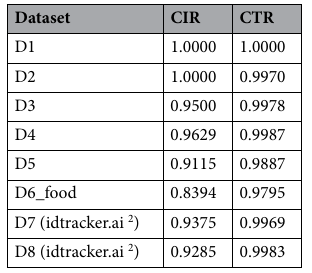
Table 3. Performance of the evaluation